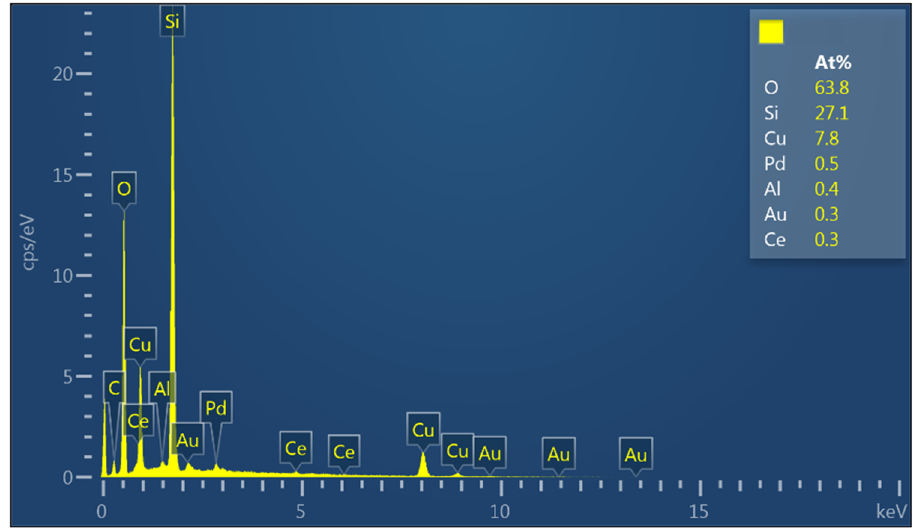
Figure 5. EDS image of modified Ce-BEA.